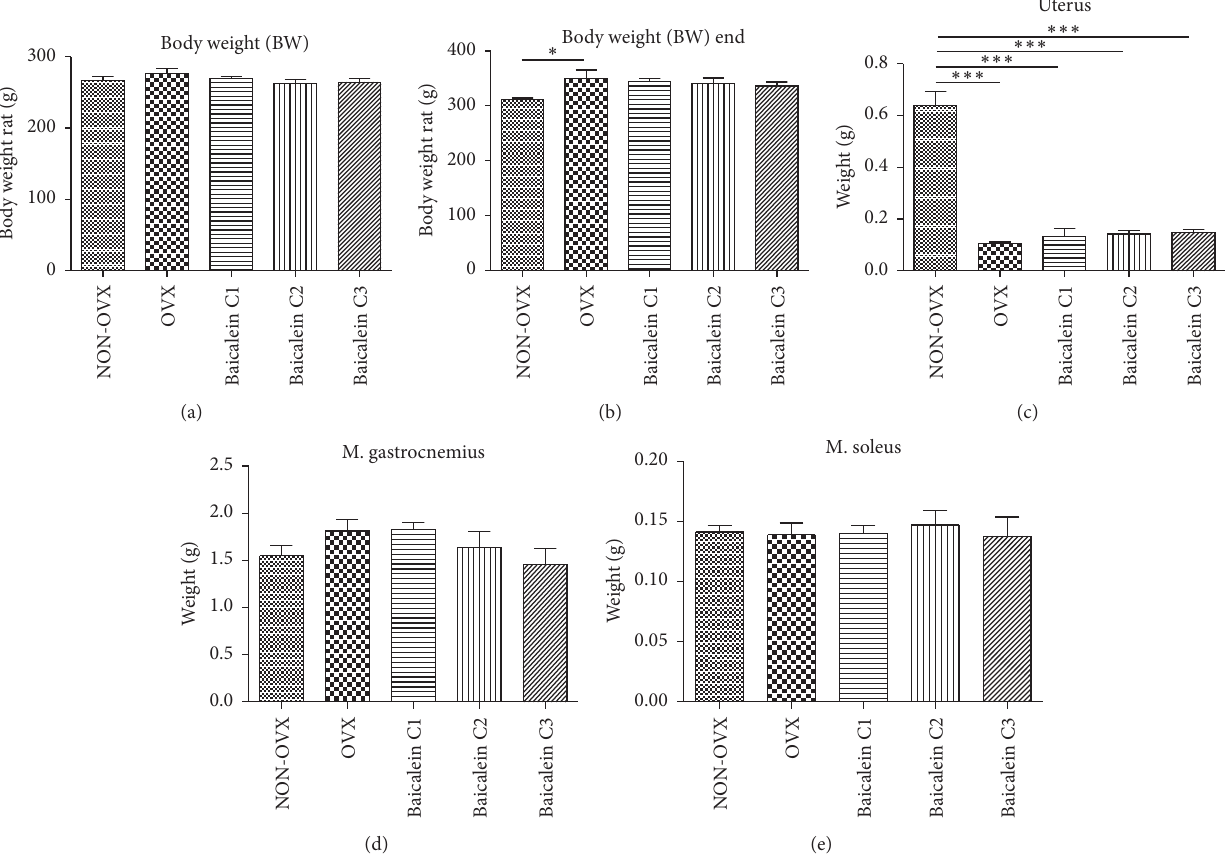
Figure 2: Body weight in the beginning (a) and end (b) of trial, weight of uteri (c), M. gastrocnemius (d), and M. soleus (e). The body weight of rats was monitored on the days of delivery ((a), 𝑛 = 48 ) and sacrifice ((b), 𝑛 = 48 ). Cohorts included nonovariectomized (NON- OVX), ovariectomized (OXV) rats, and animals treated with different baicalein concentrations (C1: 1mg/kg BW, C2: 10mg/kg BW, and C3: 100mg/kg BW). The uterus weight in NON-OVX rats was significantly greater than that in the other groups ((c), 𝑛 = 48 ). M. gastrocnemius and M. soleus were weighed after decapitation and no significant differences could be measured, while in the former a higher concentration of baicalein showed a tendency towards lower muscle weight ((d), 𝑛 = 46 ; (e), 𝑛 = 42 ). ∗ 𝑝 < 0.05 and ∗∗∗ 𝑝 < 0.001 indicate significant